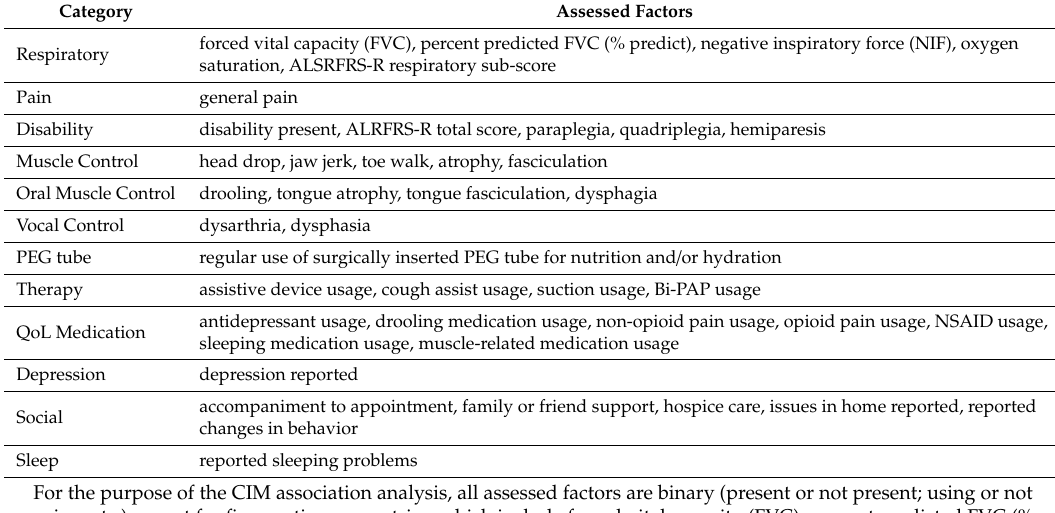
Table 2. Categories of physical health and intervention usage factors utilized to examine associations with clinical impression of mood